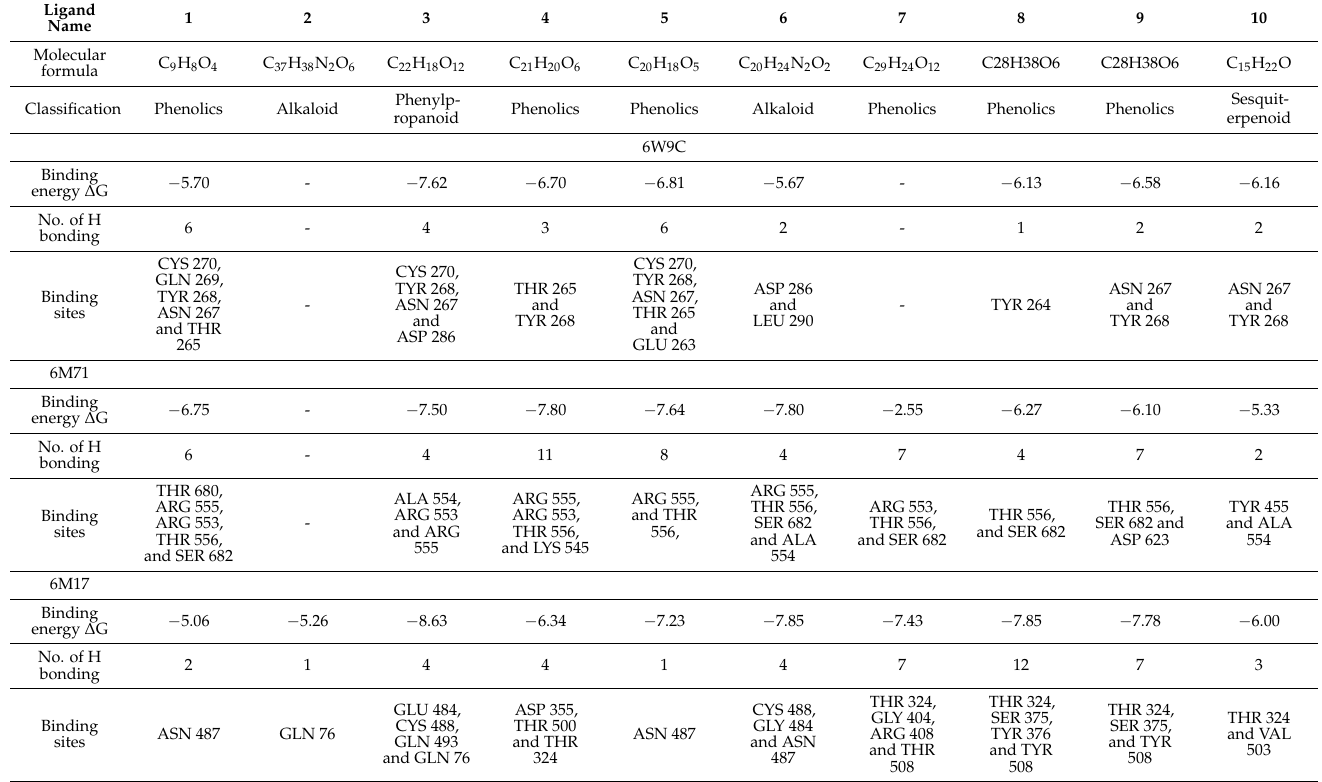
Figure 3. Chimera visualization of 6W9C docking with chicoric acid ( 1 ), curcumin ( 2 ), demothoxy- curcumin, and ( 3 ) withanolide D ( 4 ). The yellow dots show H-bonds.